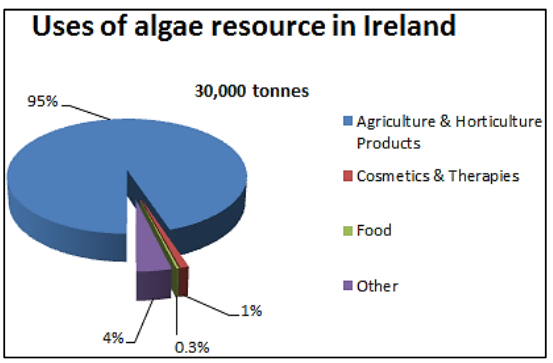
Figure 6. Uses of macroalgae in Ireland